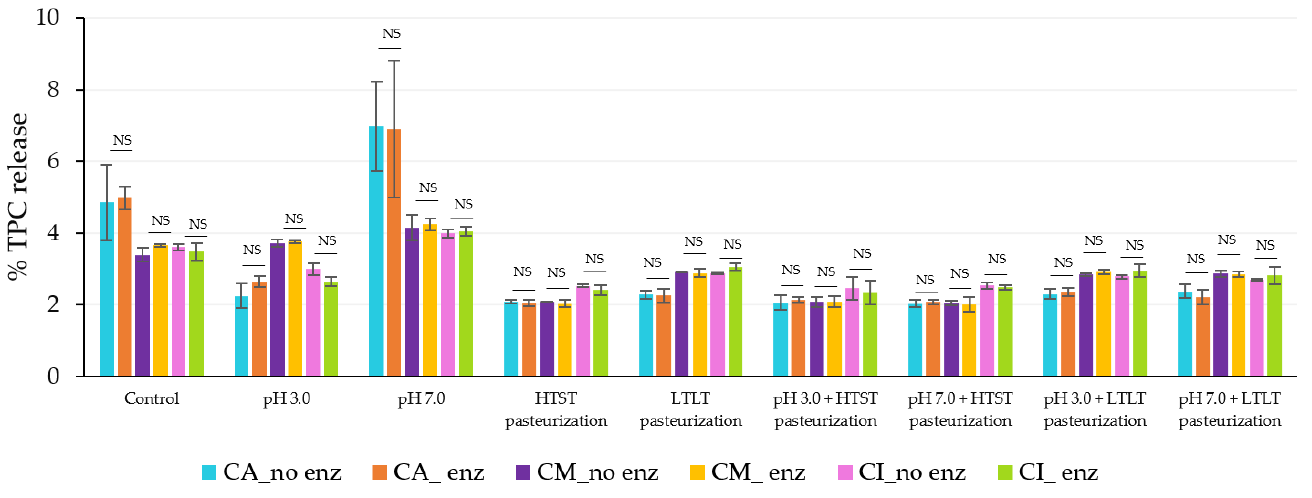
Figure 8. % TPC released during simulated gastrointestinal condition in the gastric phase (120 min) with and without pepsin. NS indicated no significant differences at p ≤ 0.05. The error bars indicate the SD of the data. The control sample was microbeads after air-drying.